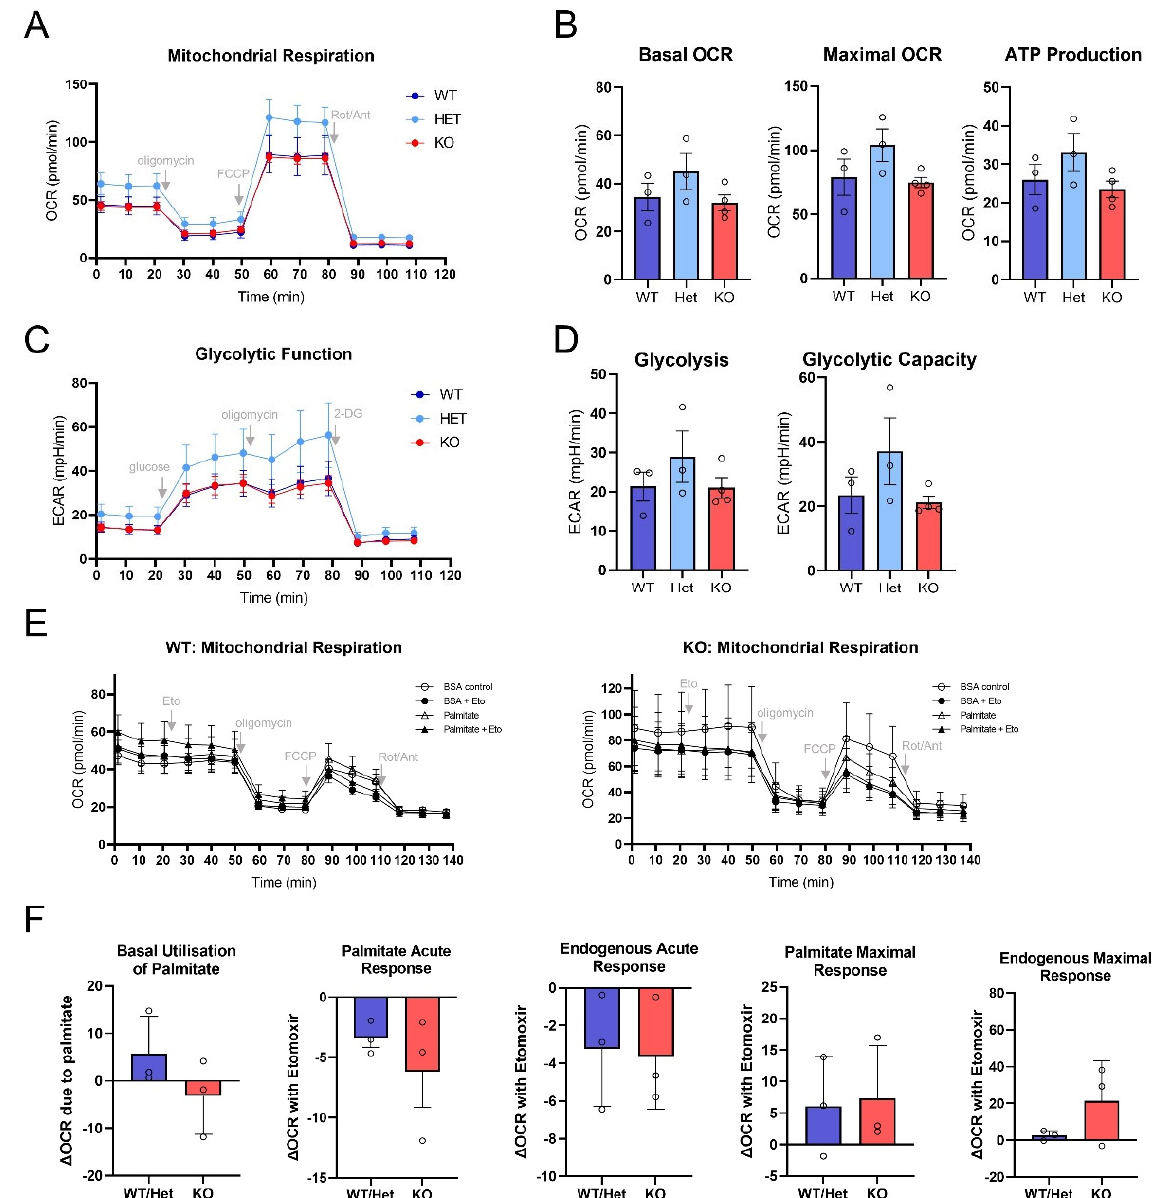
Figure 5. Granulosa cell mitochondrial metabolism, glycolysis and fatty acid oxidation are not altered in PGR null mice at ovulation. Granulosa cells were collected from PRKO mice and WT or HET littermates at 10 h post-hCG and assayed using Seahorse extracellular flux stress tests. ( A , B ) Mitochondrial stress test analysis of mitochondrial respiration capacity and ATP production. ( C , D ) Glycolysis stress test assessment of glycolytic capacity of granulosa cells. ( E , F ) Palmitate-oxidation stress test determined granulosa cell utilization of endogenous fatty acids or exogenous palmitate substrate for respiration. Values represent mean ± SEM of n = 3–4 biological replicates pooled from 1–3 mice each. No statistical differences were detected by one-way ANOVA (mitochondrial and glycolysis stress tests) or unpaired t -test (palmitate-oxidation stress